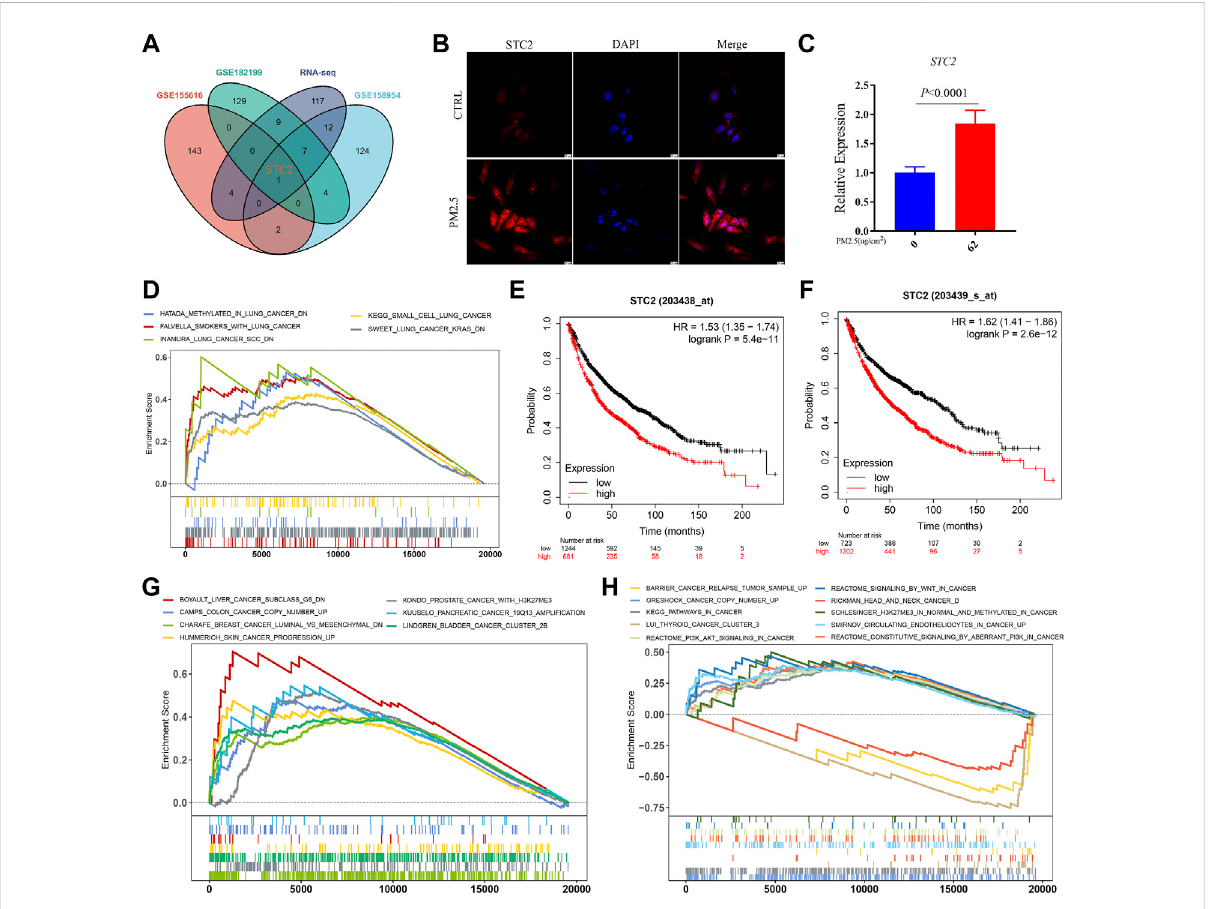
FIGURE 2 STC2 is a key gene regulated by PM2.5 and associated with multiple cancers. (A) Venn plot showing PM2.5 induced STC2 in different gene sets; (B) Immuno fl uorescence imaging showing the expression level of STC2 in different group; (C) qPCR showing the relative expression of STC2 in different group; (D) GSEA analysis showing high STC2 expression associated with lung cancer; (E,F) Kaplan-Meier OS curves showing high STC2 expression positively correlated with a poor prognosis in lung cancer; (G,H) STC2 expression was associated with a variety of